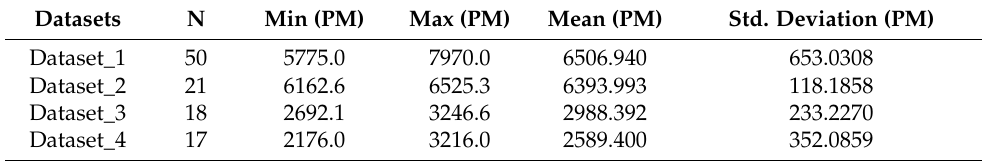
Table 4. Basic statistics about dataset